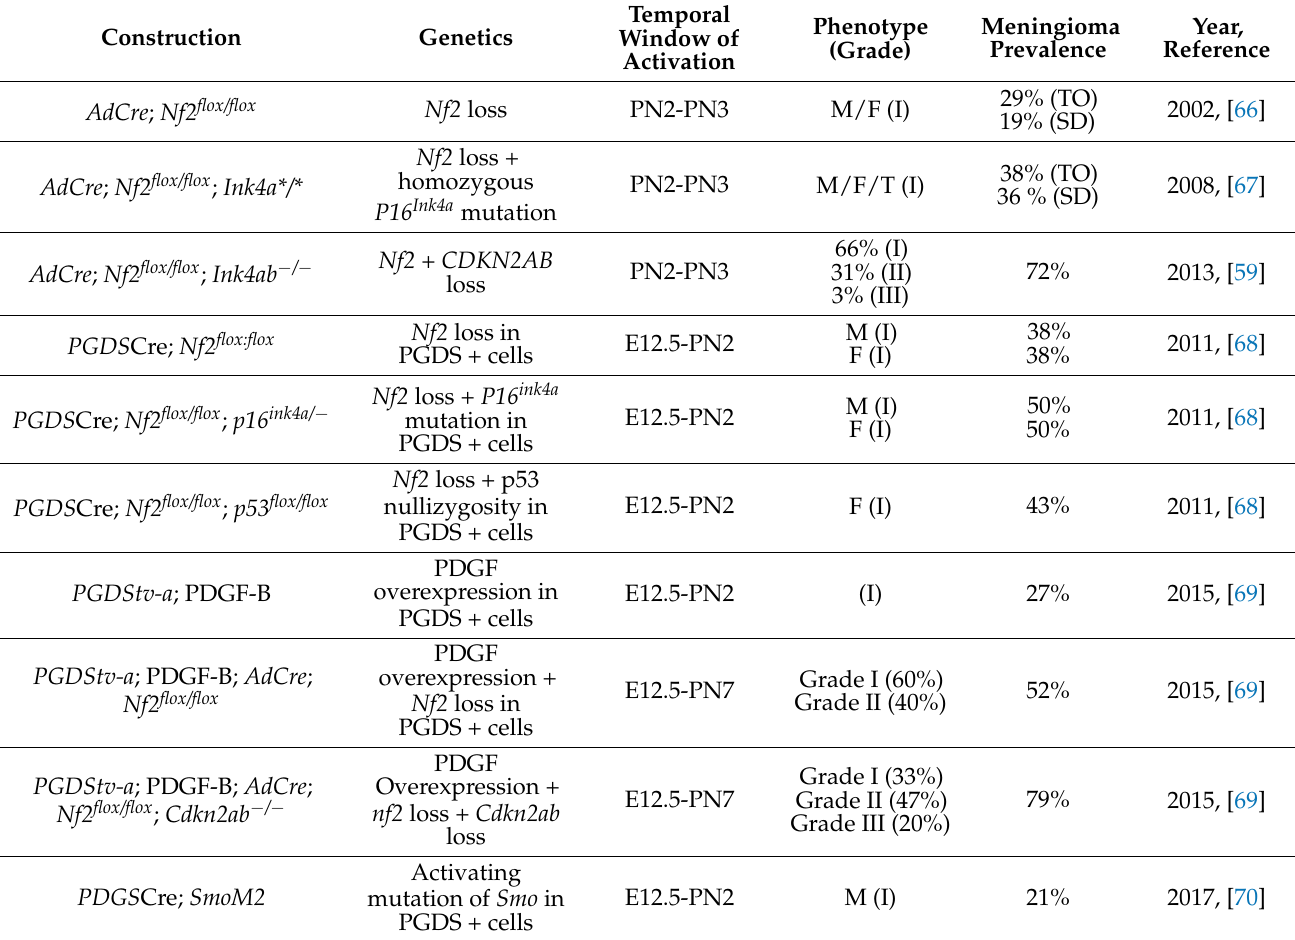
Table 3. Summary of meningioma GEMM